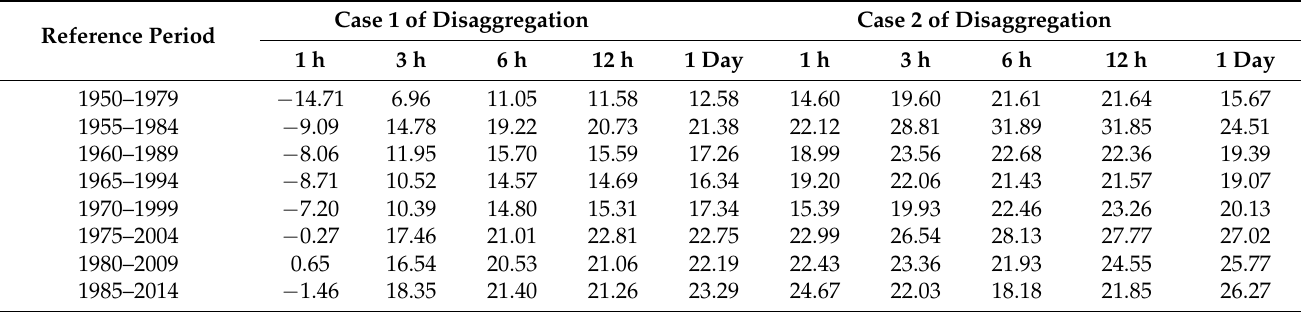
Table 1. The percentage change between the future and current climate for the mean of the 11 RCM ensemble members, 5 rainfall durations, 2 cases of rainfall disaggregation, 8 reference periods, and the 10-year return period. Reference